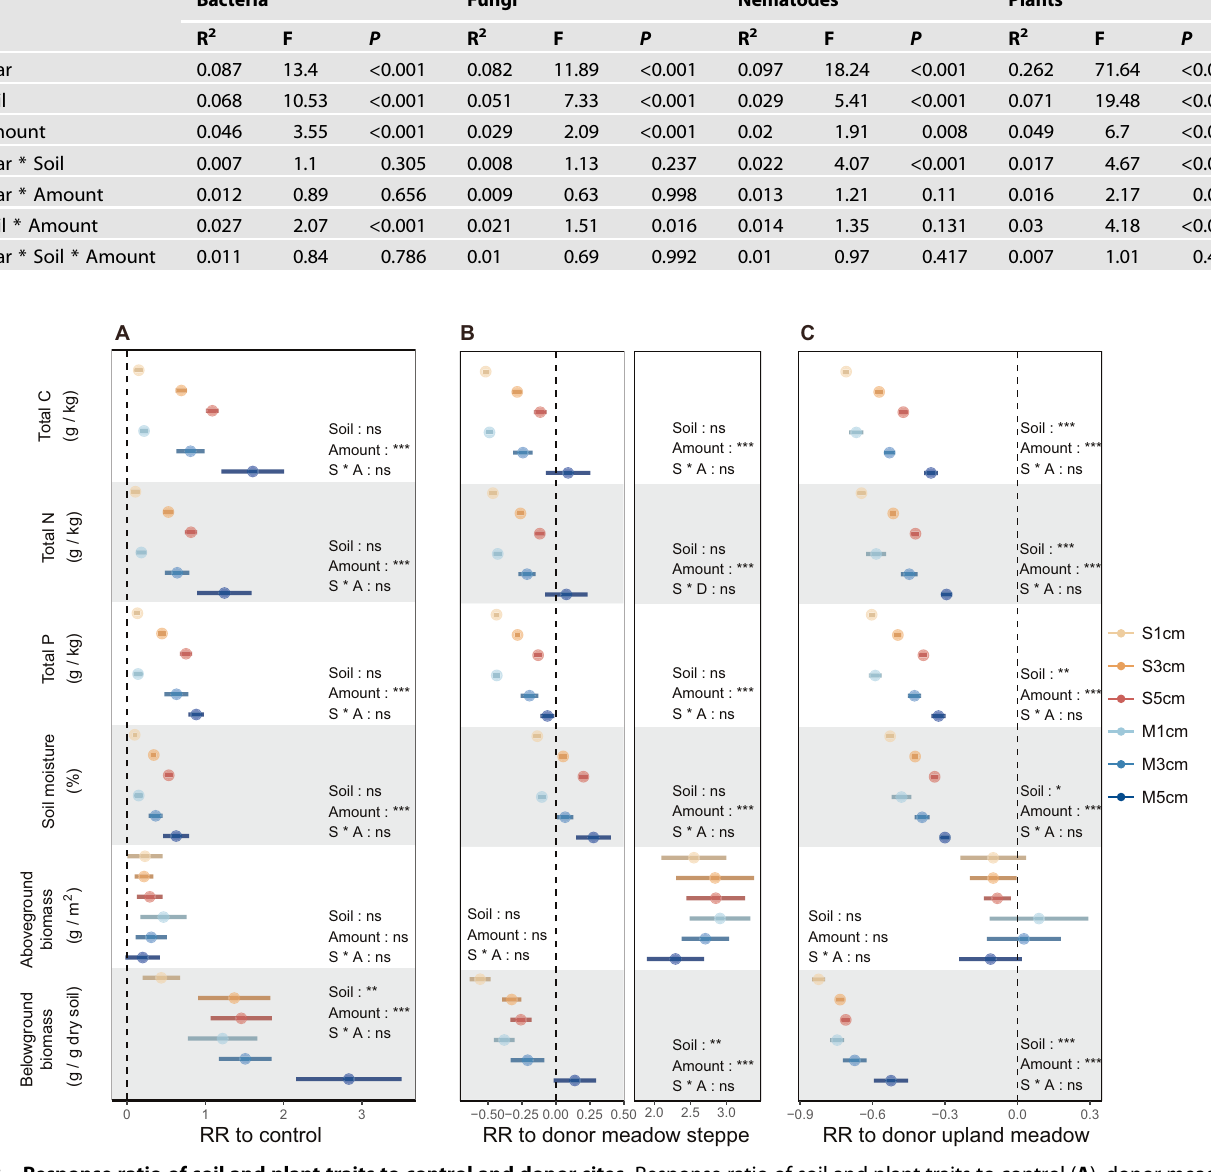
P = 0.011; upland meadow: F = 79.37, P = 0.012) but this was not affected by inoculum amount (Fig. S4). More upland meadow target species colonized in plots inoculated with upland meadow soil (F = 15.62, P < 0.001) but meadow steppe target species did not colonize more successfully in plots inoculated with meadow steppe soil than in control plots (Fig. S4). In the third year, belowground (root) biomass was signi fi cantly higher in inoculated than in control plots (F = 11.74, P < 0.01), and this effect increased with increasing amount of inoculum used (F = 11.60, P < 0.001) but no signi fi cant effect was observed for aboveground biomass (soil: F = 0.41, P = 0.53; amount: F = 0.26, P = 0.77; soil × amount: F = 0.58,